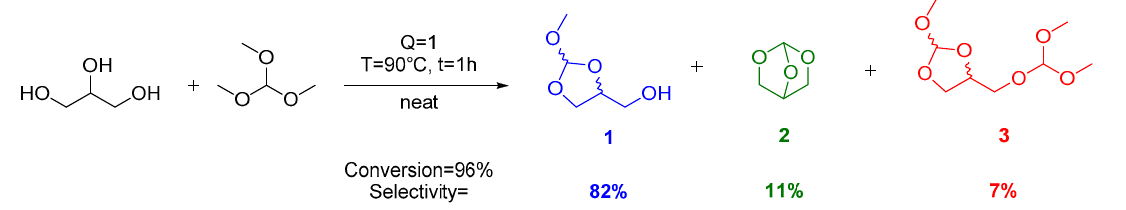
Figure 3. Reaction of Gly with HC(OMe) 3 .